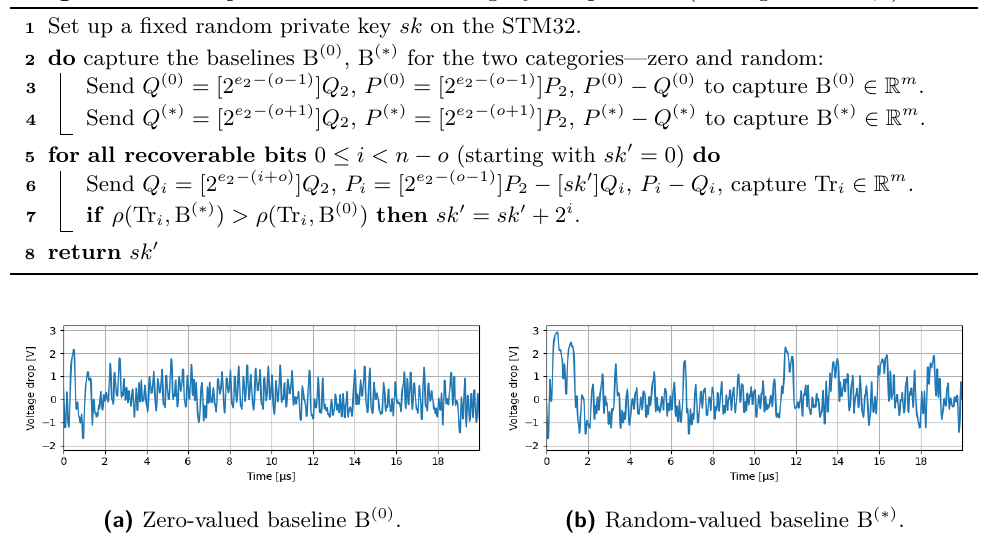
Figure 3: Examples of baseline traces corresponding to a single F cessing zero values in one case, and random (nonzero) values in the other.